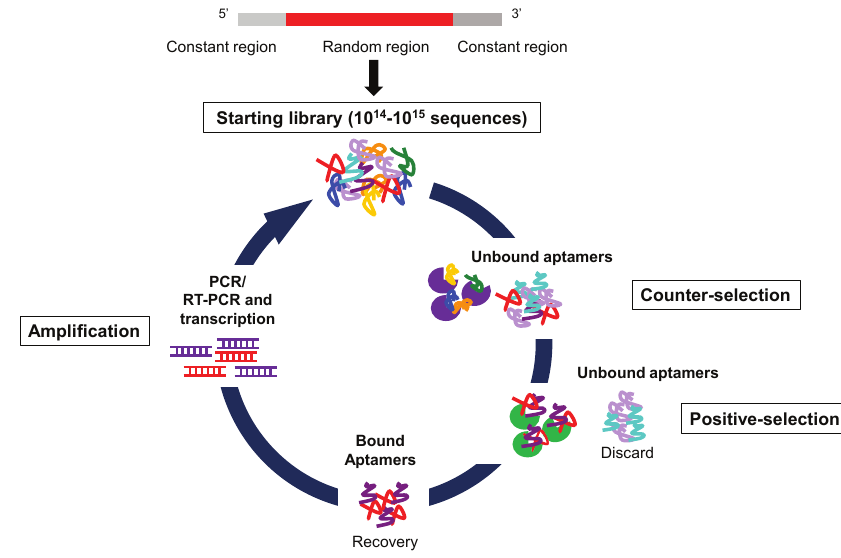
Figure 2. Schematic representation of SELEX technology. The starting RNA/DNA aptamer library is a high complexity library containing a variable region flanked by two constant regions for PCR amplification. The procedure involves reiterated rounds of: 1. Incubation of the library with nontarget molecules (counter-selection). 2. Incubation of unbound aptamers with targets (positive-selection step). 3. Recovery of bound aptamers. 4. Amplification of the bound aptamers by PCR (for DNA library) or RT-PCR and transcription (for RNA